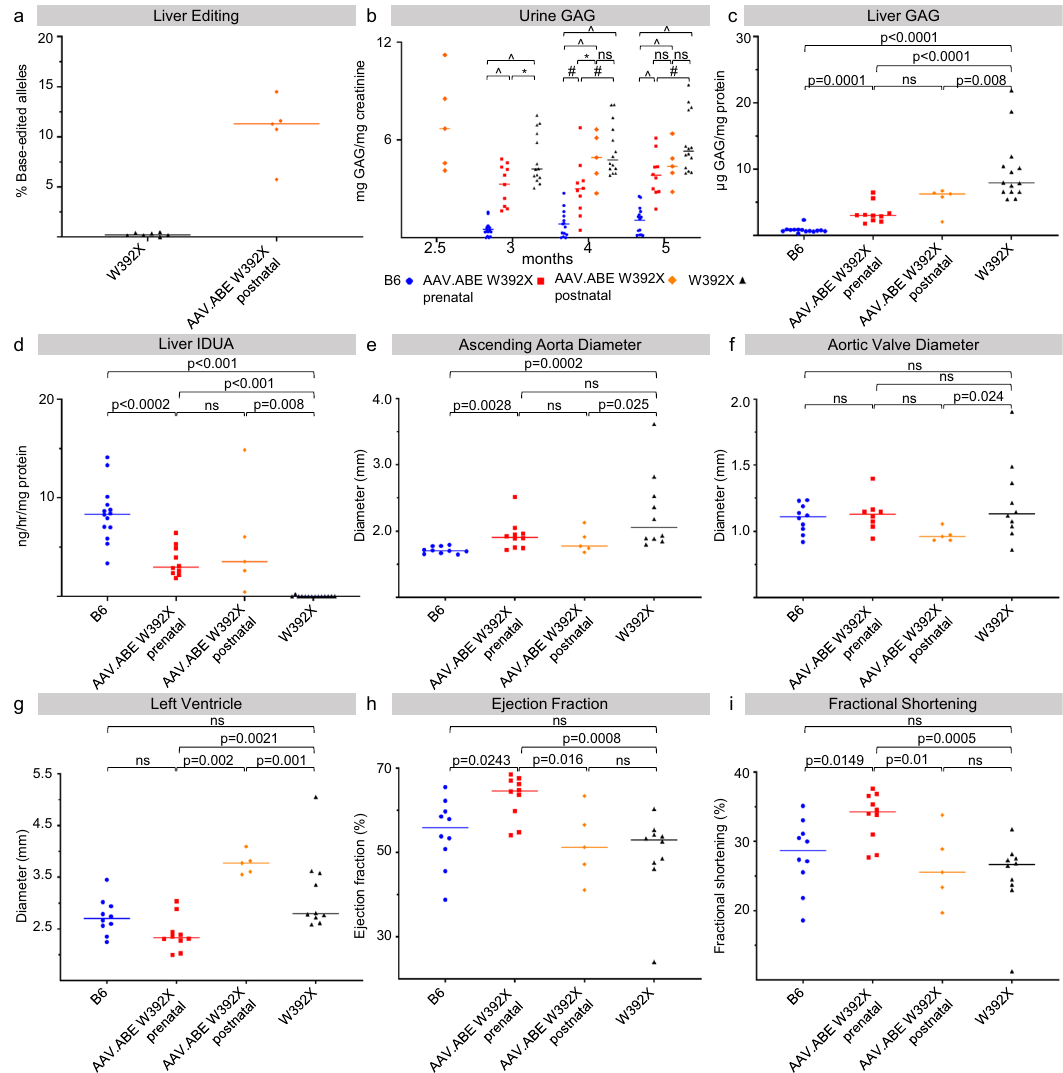
Fig. 7 Base editing in adult Idua-W392X mice partially corrects biochemical and cardiac abnormalities. Ten-week-old Idua- W392X mice were intravascularly injected with AAV.ABE.Idua. a A liver biopsy was performed at 4 months of age and genomic DNA was assessed by NGS for on-target Idua editing in postnatal Idua- W392X injected mice ( N = 5) and Idua- W392X controls ( N = 7). b Prior to postnatal injection, urine was collected for baseline urine GAG levels (2.5 month values) and urine GAGs were subsequently measured in B6 mice ( N = 14), postnatal Idua- W392X injected mice ( N = 5), prenatal Idua- W392X injected mice ( N = 10), and uninjected Idua- W392X mice ( N = 14) at 3, 4, and 5 months of age. c , d Liver GAGs ( c ) and IDUA activity ( d ) were measured from the liver biopsy specimen in postnatal Idua- W392X injected mice and compared to levels from B6 mice ( N = 14), prenatal Idua- W392X injected mice ( N = 10), and uninjected Idua- W392X mice ( N = 14). e – i Postnatal injected Idua- W392X mice ( N = 5) underwent echocardiogram at 4 months of age and the ascending aorta diameter ( e ), aortic valve diameter ( f ), left ventricle diameter ( g ), LV ejection fraction ( h ), and LV fractional shortening ( i ) were compared to those in 4-month-old B6 mice ( N = 10), prenatal Idua- W392X injected mice ( N = 10), except 4-month aortic valve diameter, ( N = 8), and uninjected Idua- W392X mice ( N = 10). ^ p < 0.0001; # p < 0.001; * p < 0.05. Exact p values outlined in Table S1. Wilcoxon test for multiple comparisons used to assess 3-month urine GAGs and liver IDUA activity. All remaining statistical analyses used Student ’ s t -test with α = 0.05. All tests were two-sided. GAG glycosaminoglycans, IDUA a- L -iduronidase. AAV.ABE indicates AAV.ABE.Idua. Source data are provided as a Source Data fi